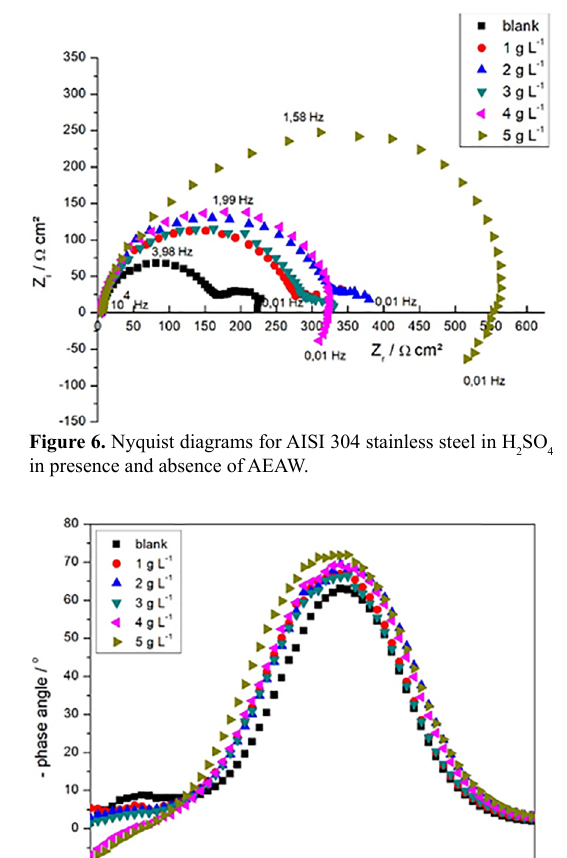
Figure 7. Bode phase angle plots for AISI 304 stainless steel in SO in presence and absence of AEAW. H 2 4